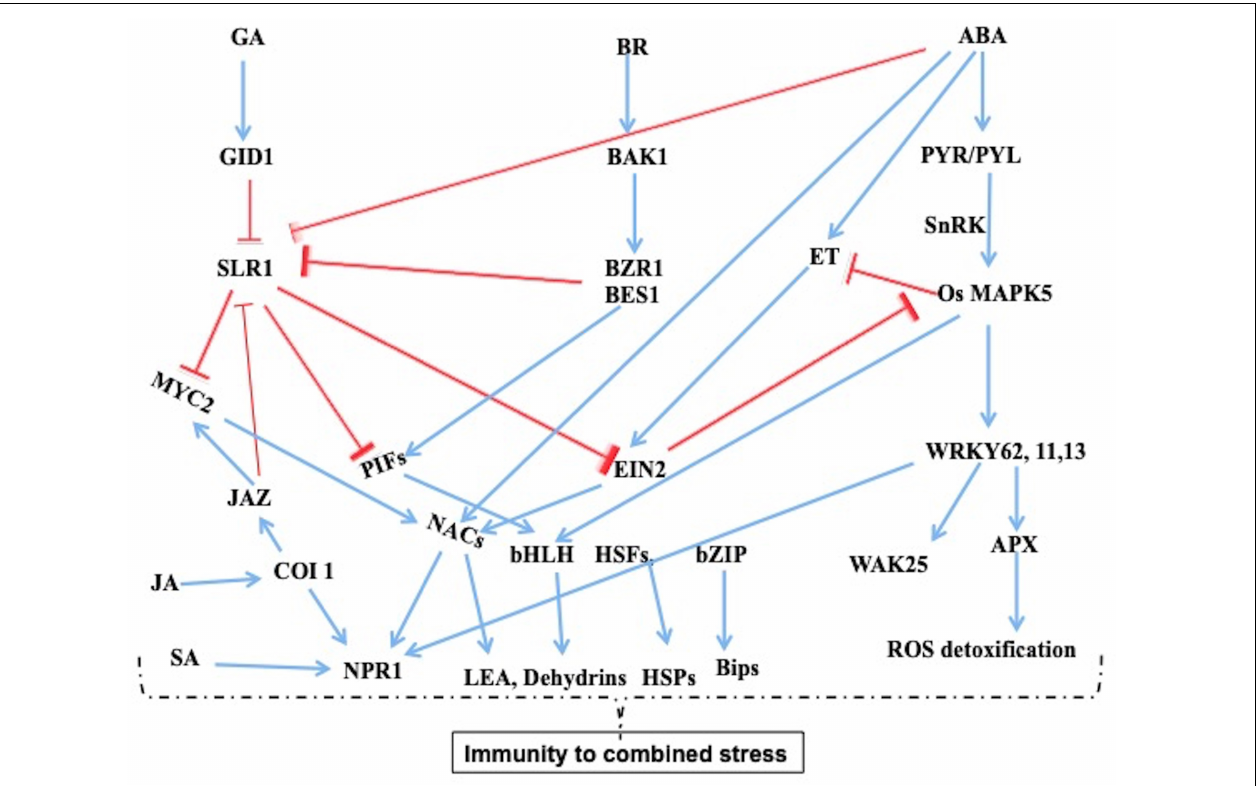
FIGURE 2 | Regulatory networks under combined stress of drought and Xoo infection in nee. The data taken from the combined stress transcriptomic studies and a model arrived from the knowledge from diverse studies. The phytohormones play crucial role in crosstalk signaling mechanisms. Some of the key genes play antogonistic, overlapping, and opposite role with response to combined stress which depends on intensity of stress and cellular homeostasis with regards protein turnover or stability. The LEAs. dchydrins, HSPs, Bips provide stability to proteins (Narsai et al., 2013; Sharma et al.,